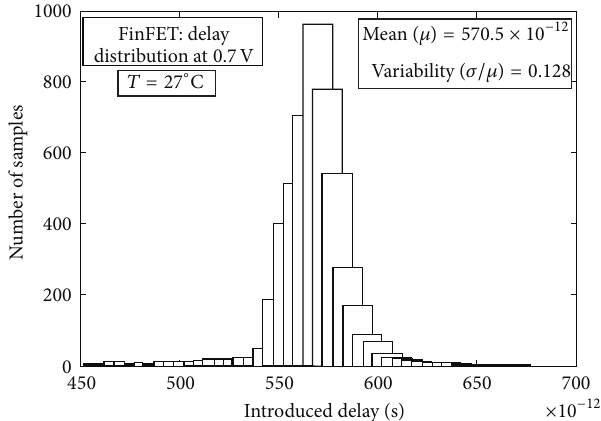
Figure 14: Introduced delay distribution plot of the FinFET based proposed buffer delay circuit.